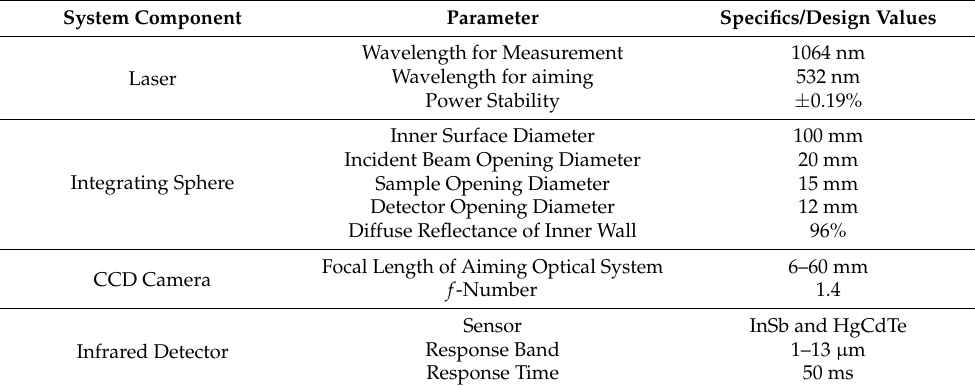
Table 1. Main technical parameters of the